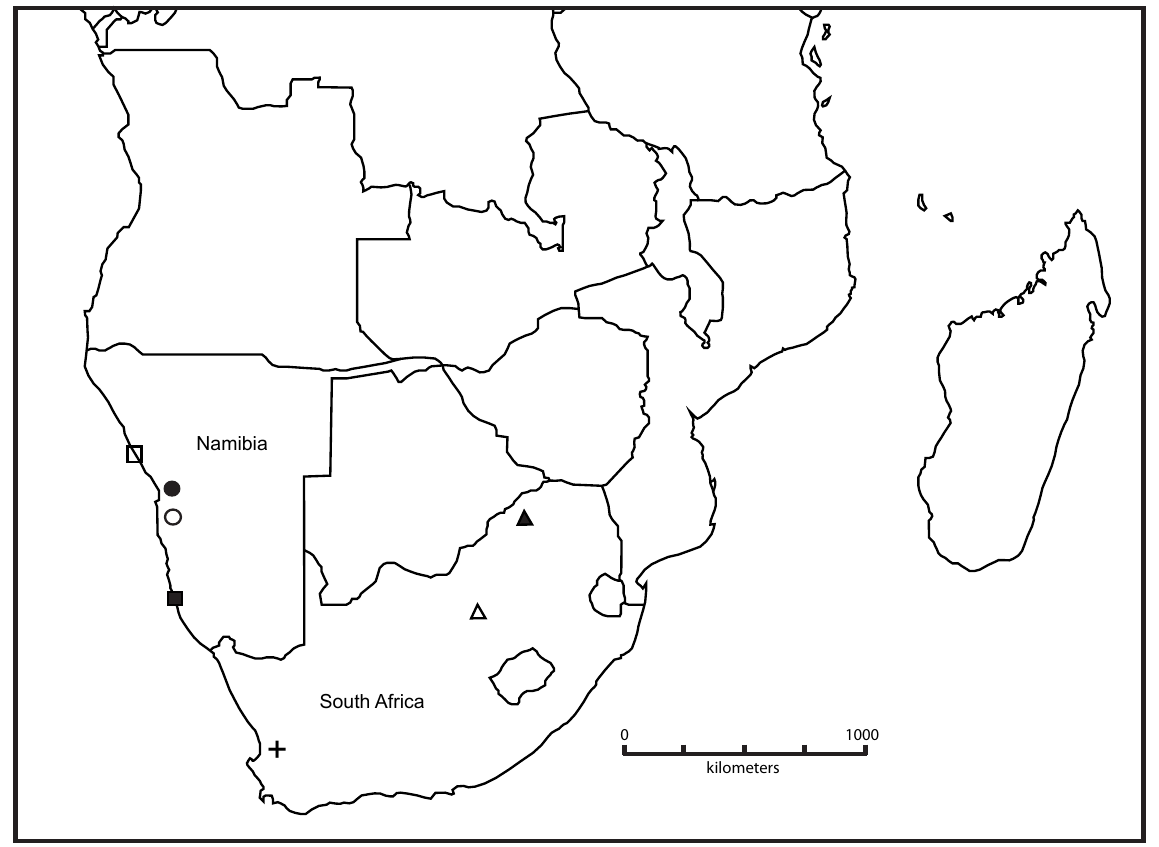
Fig. 4. Distribution of Cyrioctea species in Africa: (■) = C. griswoldorum Platnick & Jocqué, 1992; (□) = C. hirsuta Platnick & Griffin, 1988; ( △ ) = C. lotzi sp. nov.; (▲) = C. marken Platnick & Jocqué,